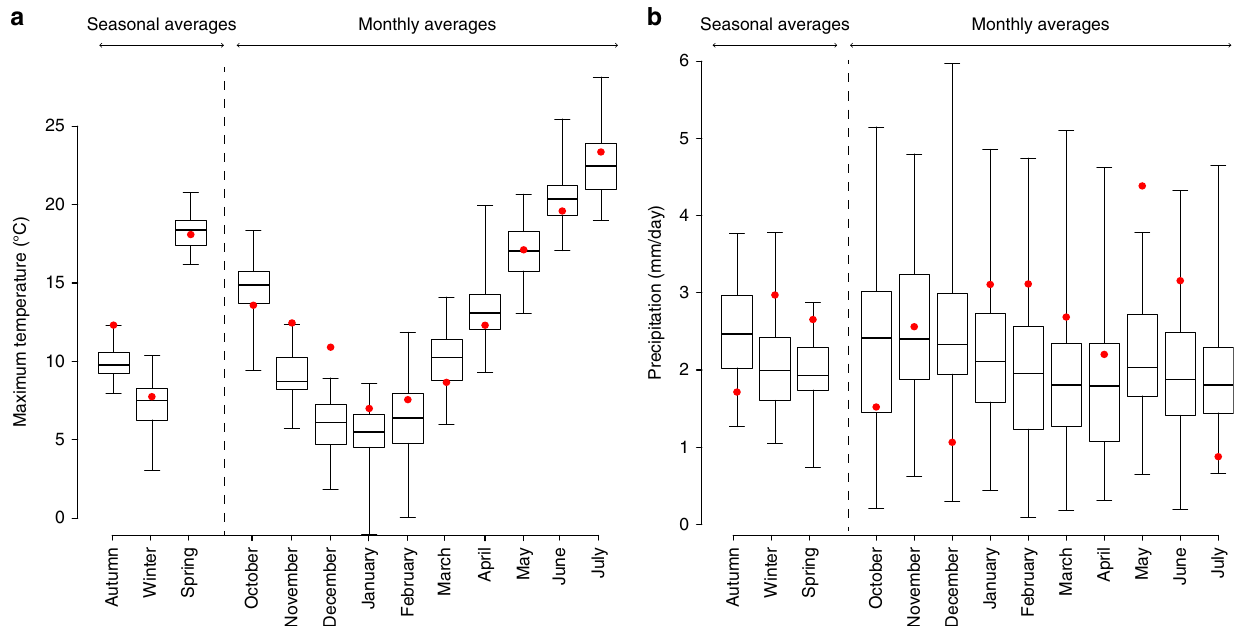
Fig. 2 Maximum temperatures and precipitation over the 1959 – 2016 wheat growing seasons. Boxplot of a daily maximum temperature and b daily precipitation averaged each year over the study area for the period 1959 – 2015. Whiskers extend to maximum and minimum values. Values in the 2015 – 2016 growing season are presented as red dots (for other climate variables see Supplementary Fig.